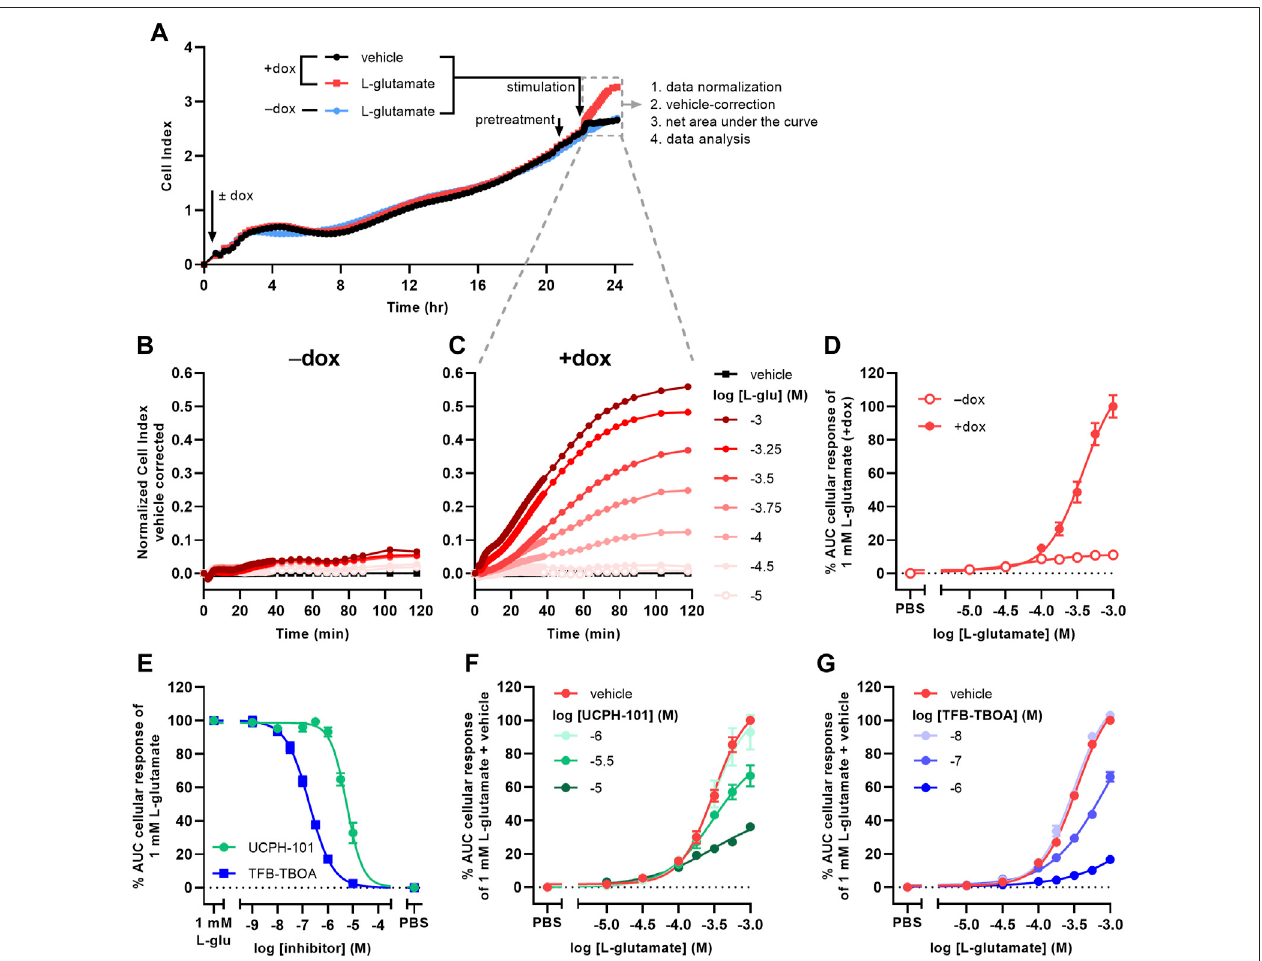
FIGURE 2 | L-glutamate induces EAAT1-speci fi c cellular responses on JumpIn-EAAT1 cells. (A) Experimental layout of an xCELLigence growth curve, the subsequent assay course and data analysis. Shown are traces oftwo separate wells from arepresentative experiment. (B,C) Vehicle-corrected nCI traces of cells in the absence ( − dox) (B) or presence (+dox) (C) of doxycycline stimulated with vehicle (PBS) or L-glutamate (L-glu), shown as the mean of a representative experiment performed in duplicate. (D) Combined concentration-response curves of L-glu on JumpIn-EAAT1 cells (±dox). (E) Combined concentration-inhibition curves of TFB-TBOA and UCPH-101 on +dox cells pretreated for 1 h with vehicle (PBS/DMSO) or increasing concentrations of TFB-TBOA or UCPH-101 and subsequently stimulated with a submaximal concentration (1 mM) of L-glu. (F) Combined concentration-response curves of L-glu on +dox cells pretreated for 1 h with vehicle (PBS/ DMSO), 1 μ M, 3.16 µM or 10 µM UCPH-101. (G) Combined concentration-responsecurves ofL-glu on +dox cells pretreated for1 h withvehicle(PBS/DMSO), 10 nM, 100 nMor1 µMTFB-TBOA.CellularresponseisexpressedasthenetAUCofthe fi rst120 minafterL-glustimulation.Dataarenormalizedtotheresponseof1 mML-glu on +dox cells. Data are shown as the mean ± SEM of three to ten individual experiments each performed in duplicate.